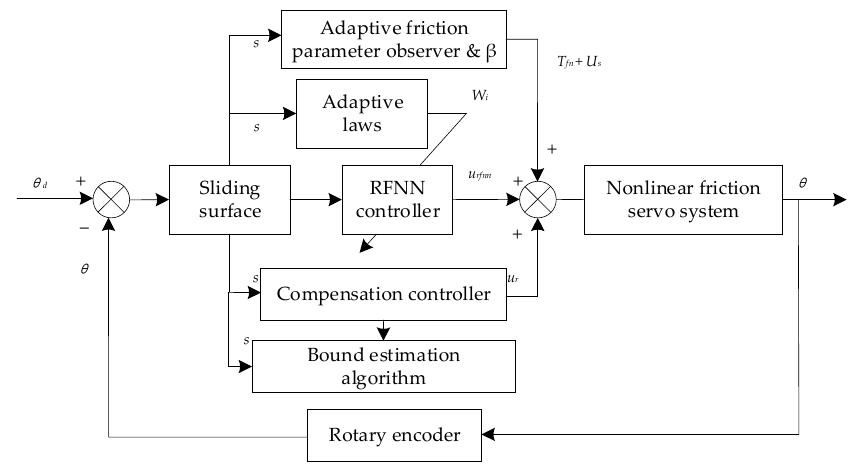
Figure 11. Block diagram of the proposed control system [77].